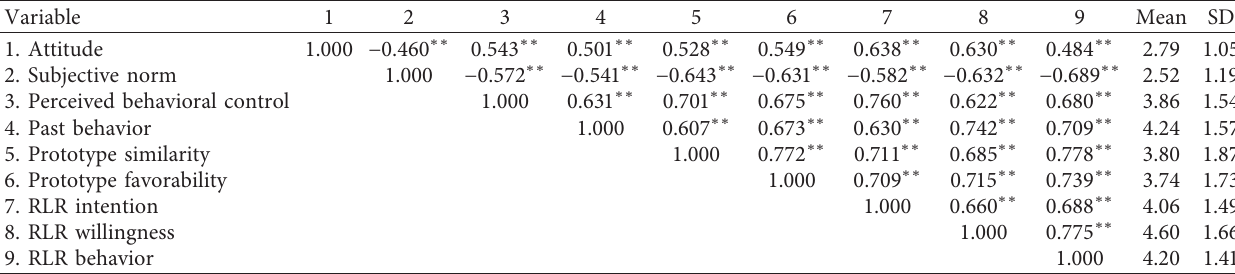
Table 2: Means, standard deviations, and bivariate correlations for all study variables.